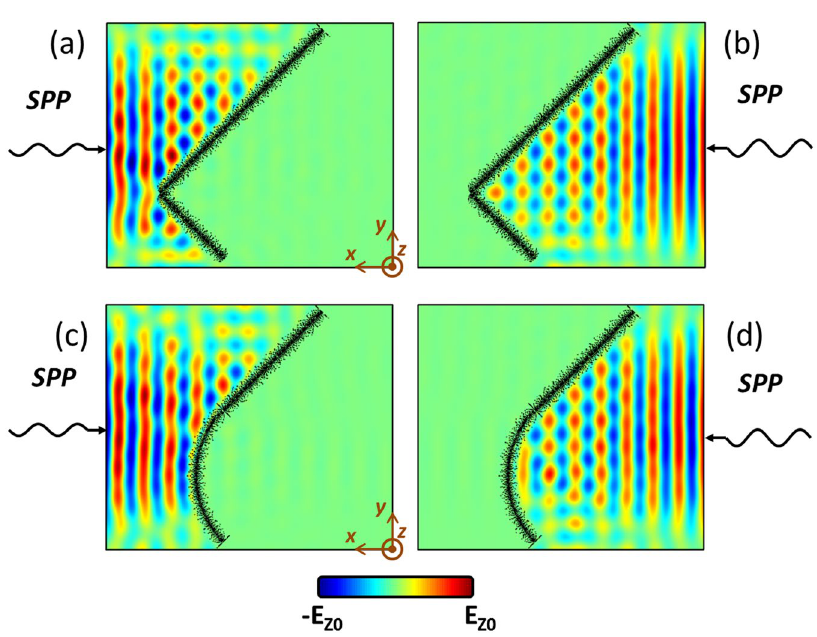
Figure 8. Field distributions of composite structures of the EM fence at 8 THz. ( a , b ) A right-angle corner composite EM fence. ( c , d ) A rounded-corner composite EM